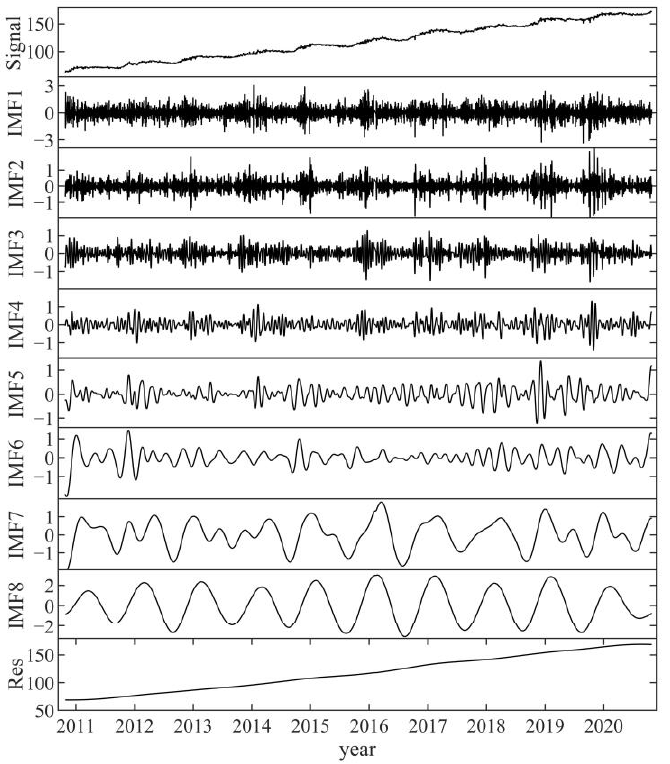
Figure 4. Decomposed results based on the CEEMD method in N direction of GNSS station P242.